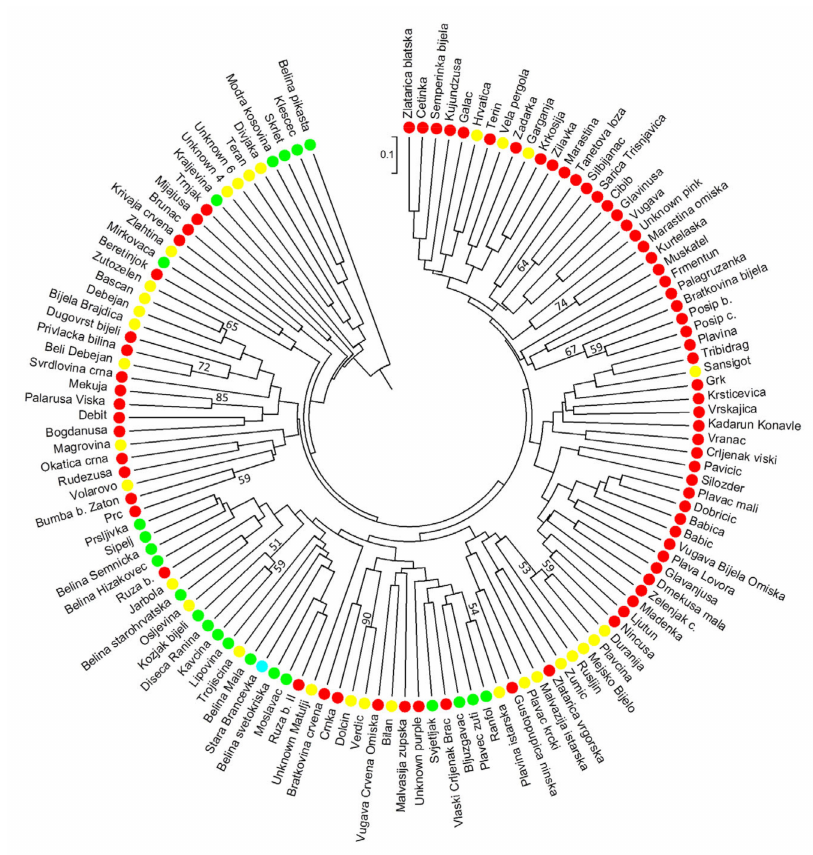
Figure 3. Circular UPGMA (Unweighted Pair Group Method with Arithmetic Mean) dendrogram for 127 presumably Croatian varieties based on 36 SSR loci. Dots represent varieties’ cultivation region: red = Dalmatia, yellow = Istria and the Croatian Littoral; green = northwestern Croatia; blue = Slavonia and Danube region.